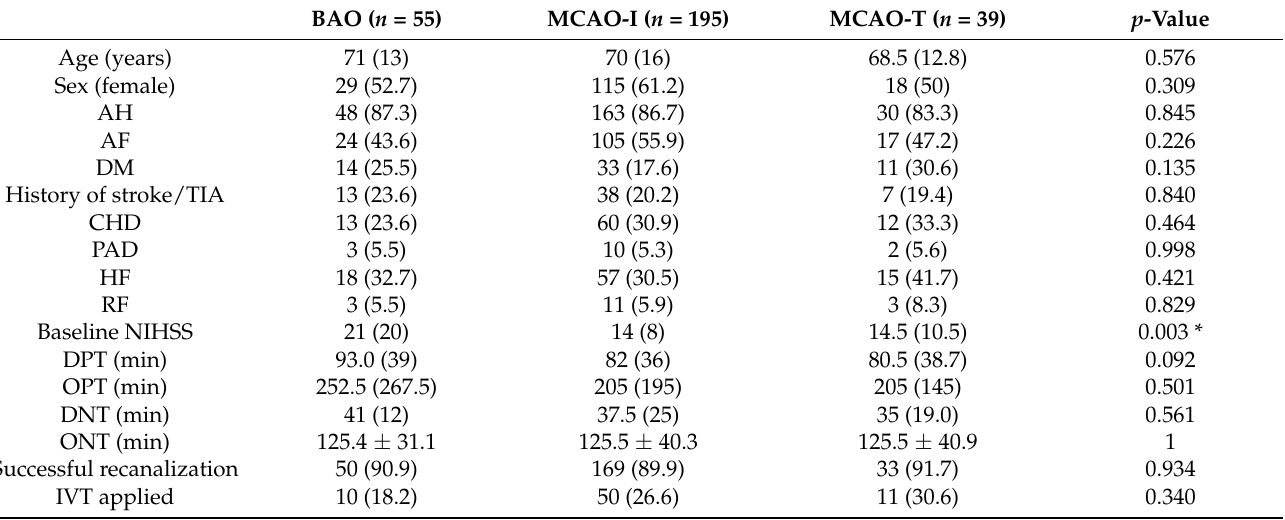
Table 2. Baseline characteristics of the study population in BAO, MCAO-I, and MCAO-T